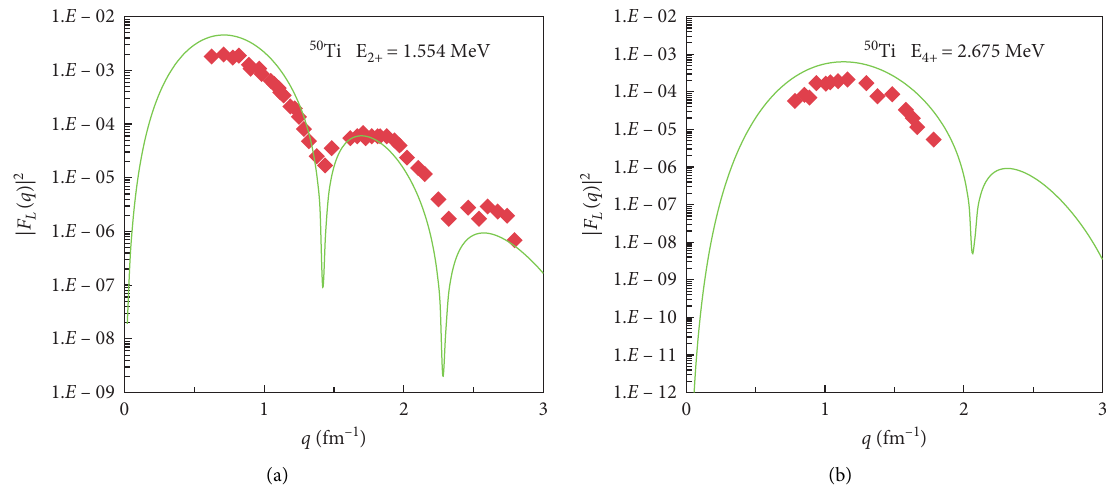
Figure 3: Inelastic longitudinal form factors of 50 Ti. (a) E(2 + ) transition, the practical data are taken from reference [4]. (b) E(4 + ) transition, the practical data are taken from reference